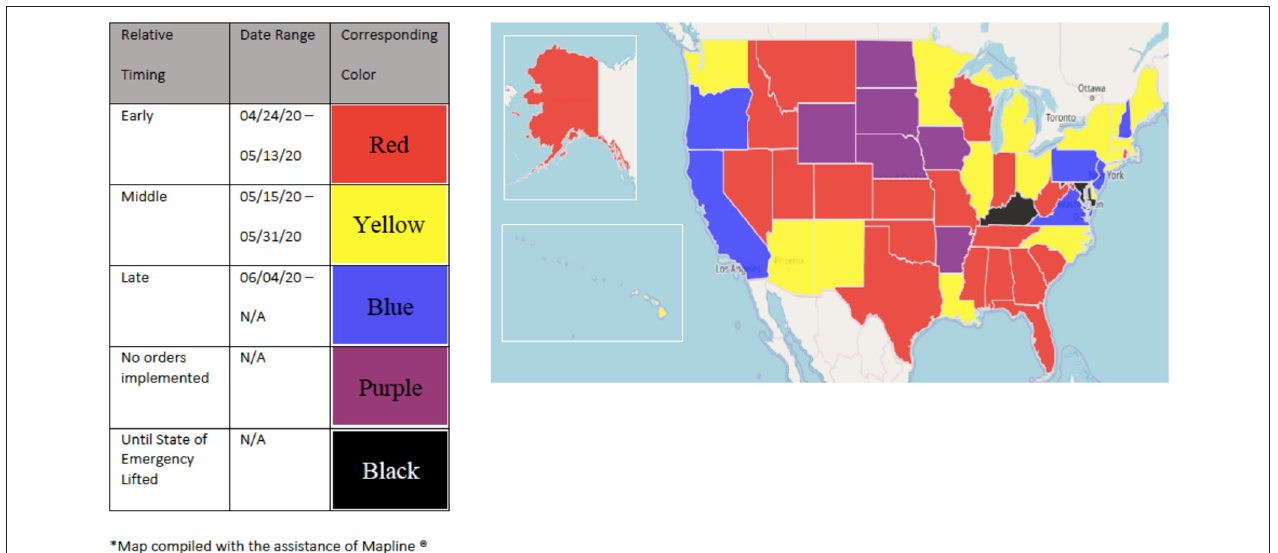
FIGURE 4 | Stay-at-home orders lifted.